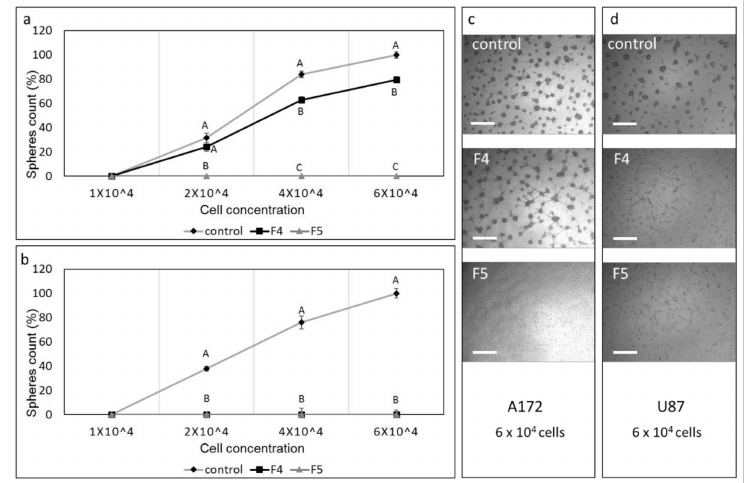
Figure 10. Assay for colony formation of A172 and U87 cells following treatments with F4 and F5. Percentage of colonies (out of the average number of colonies in the control at the highest cell concentration [6 × 10 4 ]) following treatment of ( a ) A172 with F4 (20 µ g/mL) or F5 (16.5 µ g/mL) and ( b ) U87 cells with F4 (12 µ g/mL) or F5 (10 µ g/mL) for 24 h. Cells were sorted to live cells, and these were seeded under conditions that promote neurosphere formation. Error bars indicate ± SE ( n = 3). Levels with different letters are significantly different from all combinations of pairs according to the Tukey–Kramer honest significant difference (HSD; p ≤ 0.05). ( c – d ) Examples of images used to count colonies in 6 × 10 4 cell cultures. Scale bars = 500 µ m. Control is vehicle control (0.5% v / v methanol).